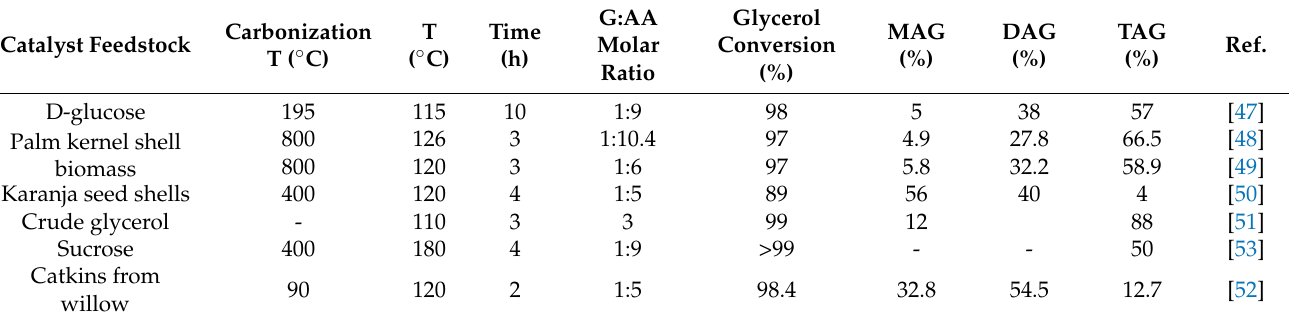
Table 3. Selectivity of all above described catalysts according to the optimal carbonization tempera- ture and reaction